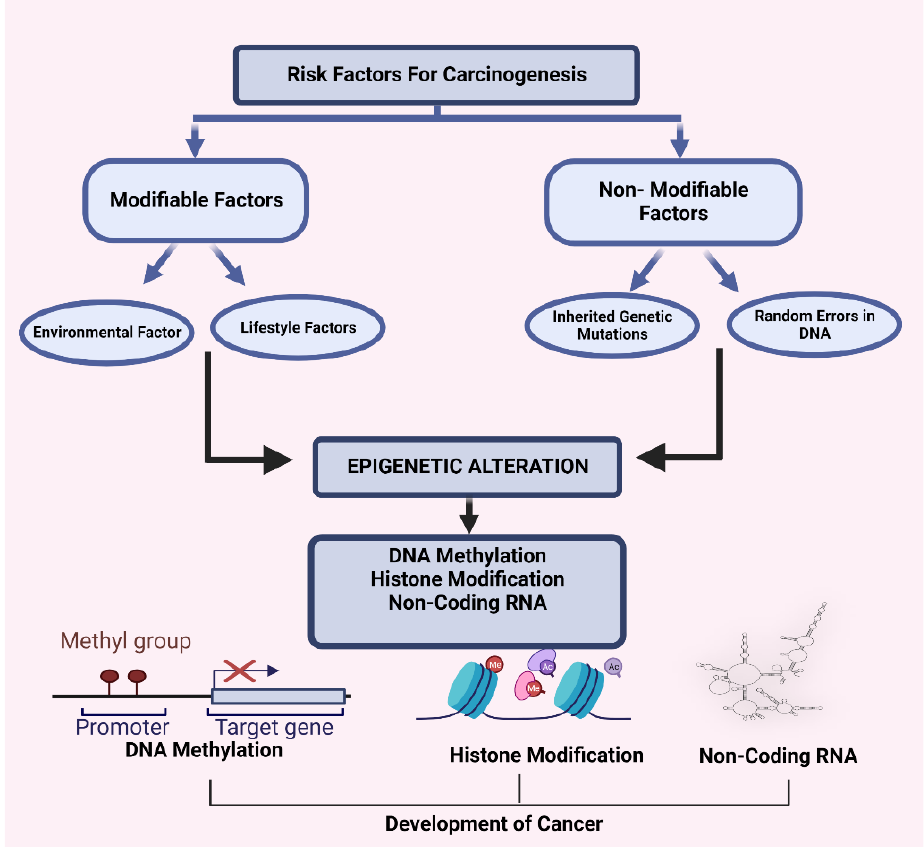
Figure 3. Possible hypothesis regarding the mechanism of